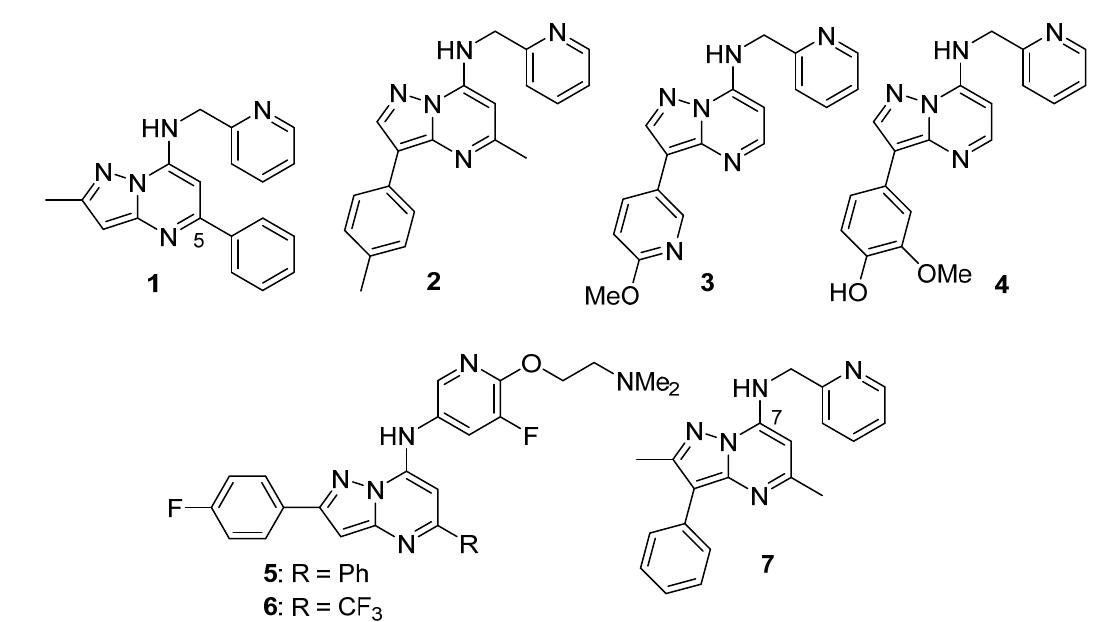
Figure 1. Pyrazolo[1,5 ‐ a ]pyrimidine ‐ based drug candidates.